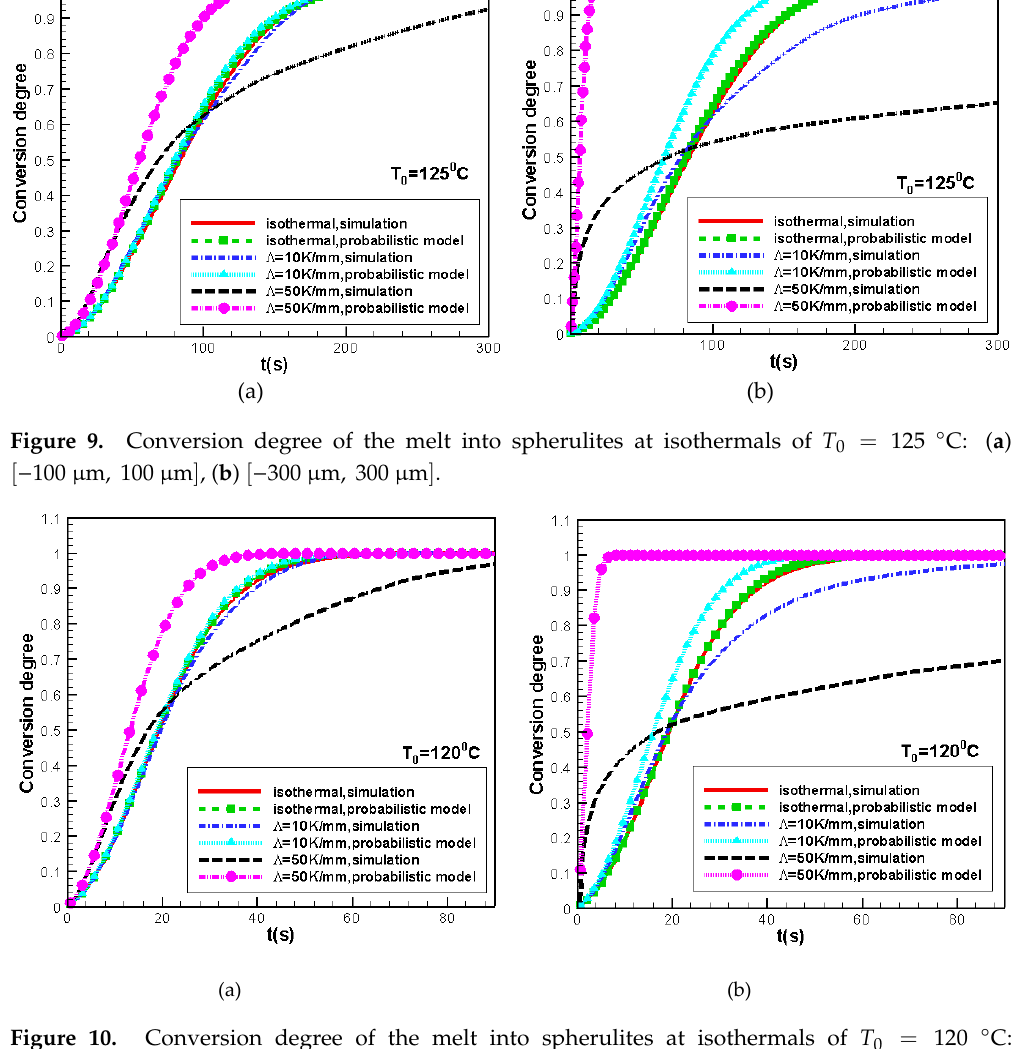
Figure 10. Conversion degree of the melt into spherulites at isothermals of C120 0